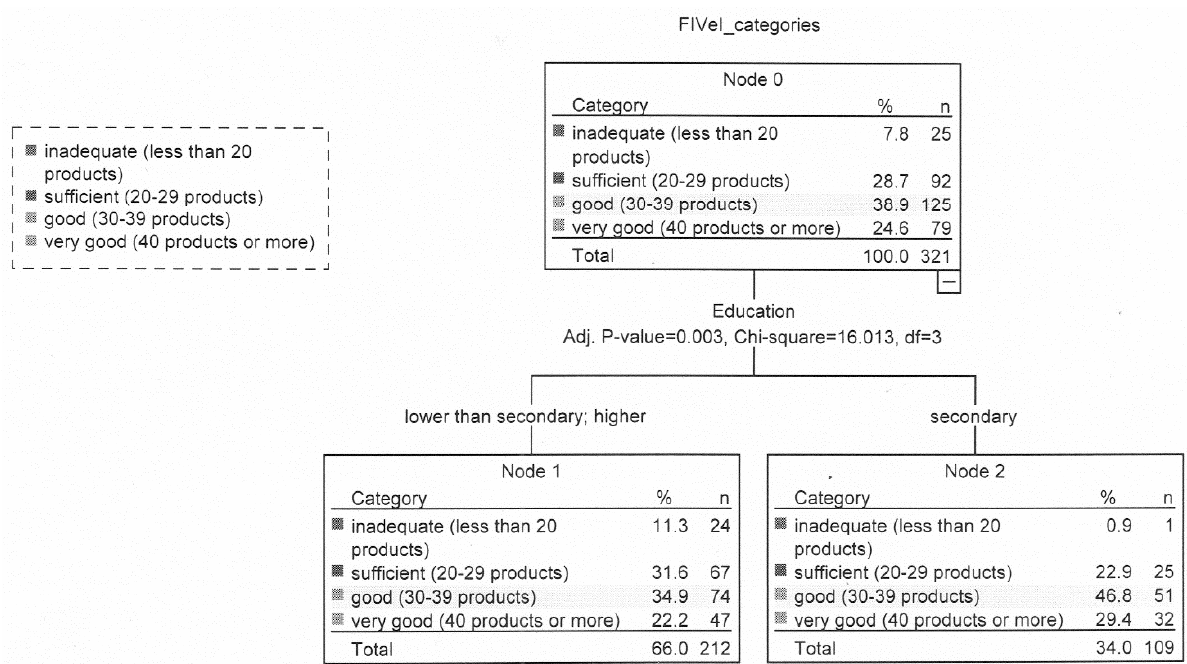
Figure 3. Relationship between food intake variety, eating addiction, selected lifestyles variables and sociodemographic characteristics in the group with